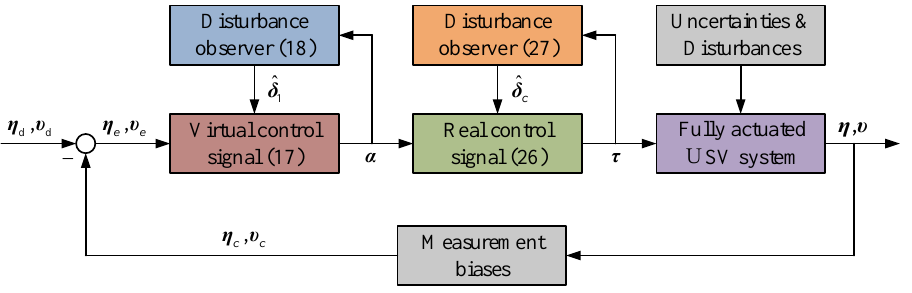
Figure 2. Structure of the proposed controller.